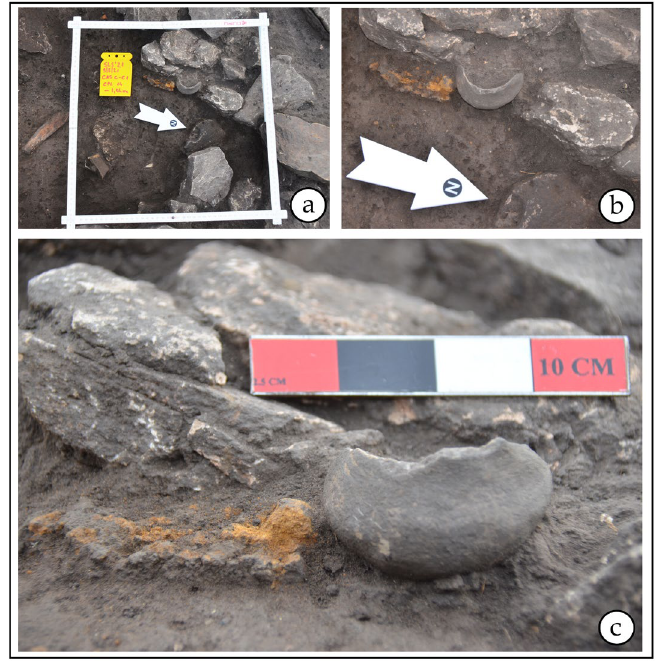
uie settlement: ( a ) context of the discovery and tea— Pe Cet ă t , ,